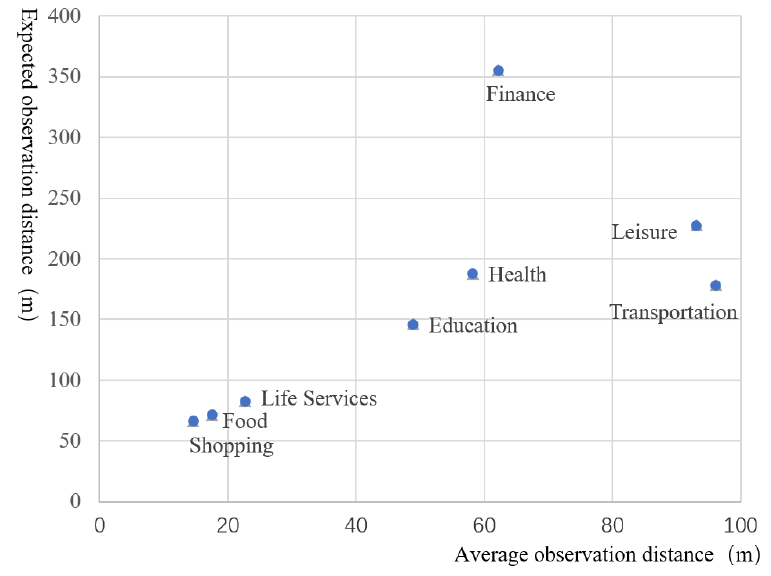
Figure 6. Scatter plot of parameters of the average nearest neighbor.